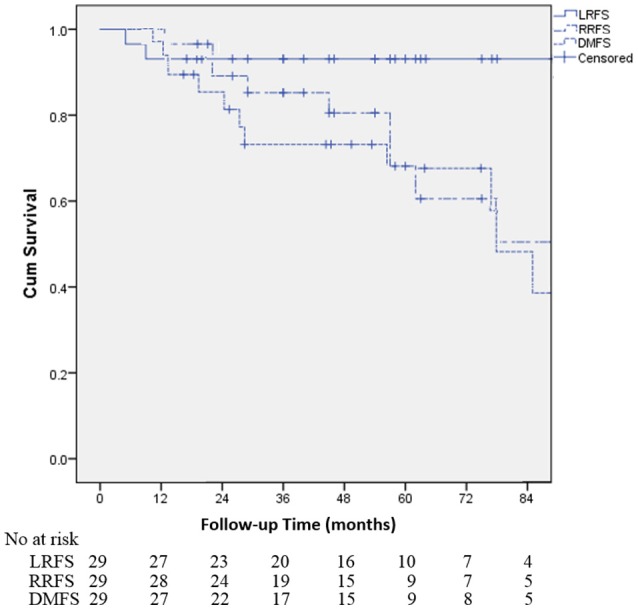
Kaplan-Meier curves for the cohort illustrating for local recurrence-free survival (LRFS), regional recurrence-free survival (RRFS) and distant metastases-free survival (DMFS).